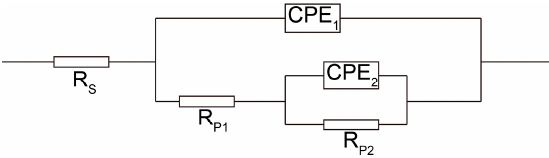
Figure 8. Equivalent circuit used to fit the data. Table 2. Fitting parameters calculated by equivalent circuit. Parameters Uncoated